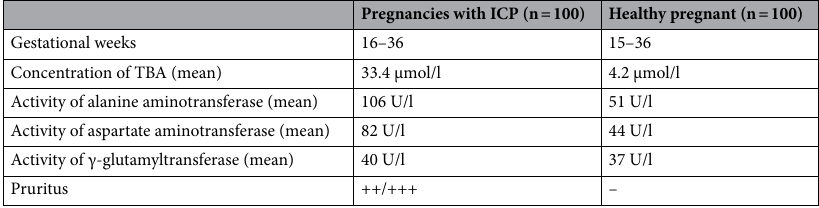
Table 1. The analysis of the general clinical data of both